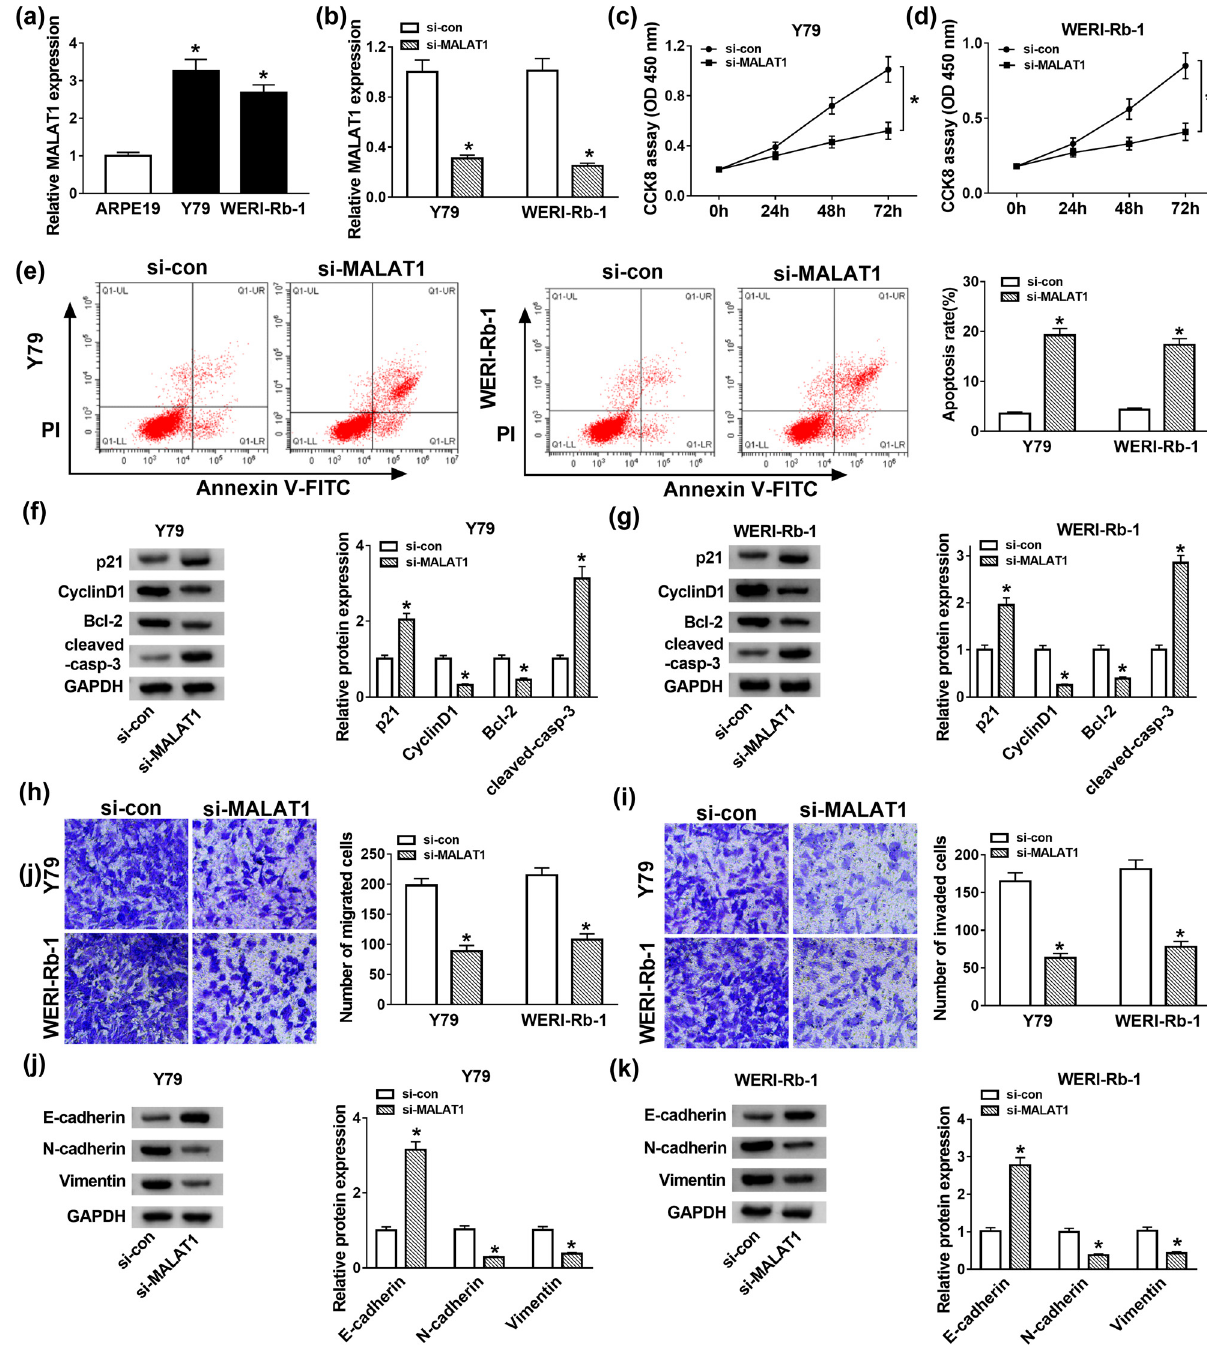
Figure 2: MALAT1 depletion suppressed cell proliferation but induced apoptosis and EMT in Y79 and WERI - Rb - 1 cells. ( a ) The expression of MALAT1 in RB cells ( Y79 and WERI - Rb - 1 ) and retinal pigment epithelial cell ARPE19 was detected by RT - qPCR. ( b – k ) Y79 and WERI - Rb - 1 cells were transfected with si - NC or si - MALAT1. ( b ) The expression of MALAT1 in Y79 and WERI - Rb - 1 cells was examined by RT - qPCR after transfection for 24 h. ( c and d ) The cell viability was detected by CCK - 8 assay after transfection for 0, 24, 48, and 72 h. ( e ) The apoptosis rate was assessed by fl ow cytometry after transfection for 48 h. ( f and g ) The protein levels of p21, Cyclin D1, Bcl - 2, and cleaved - casp - 3 were detected by western blot after transfection for 48 h. ( h and i ) After transfection for 24 h, cell migration and invasion were detected by transwell assay. ( j and k ) The protein levels of E - cadherin, N - cadherin, and Vimentin were examined by western blot after transfection for 48 h. * P <